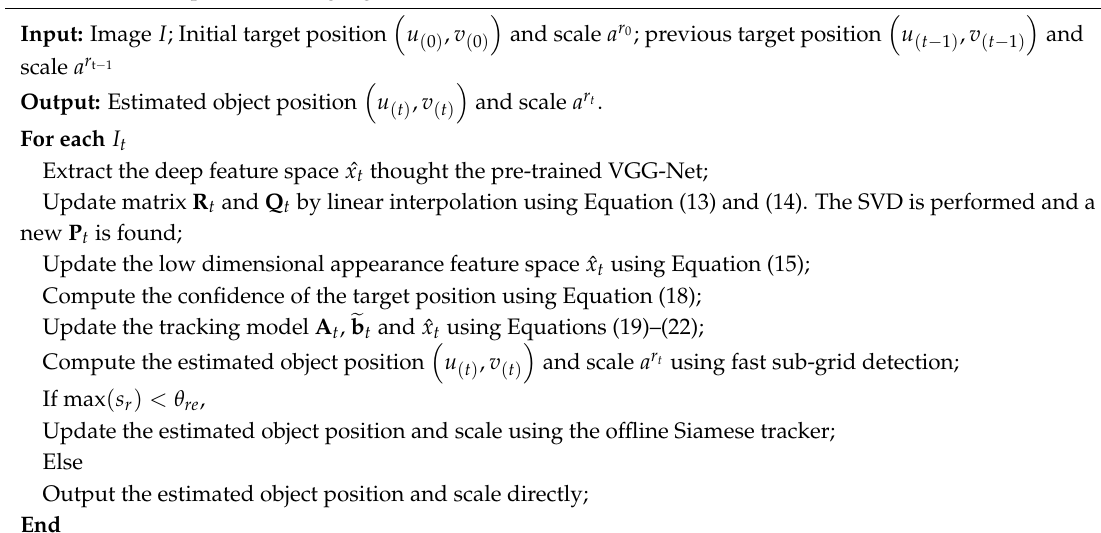
Algorithm 1: Proposed tracking